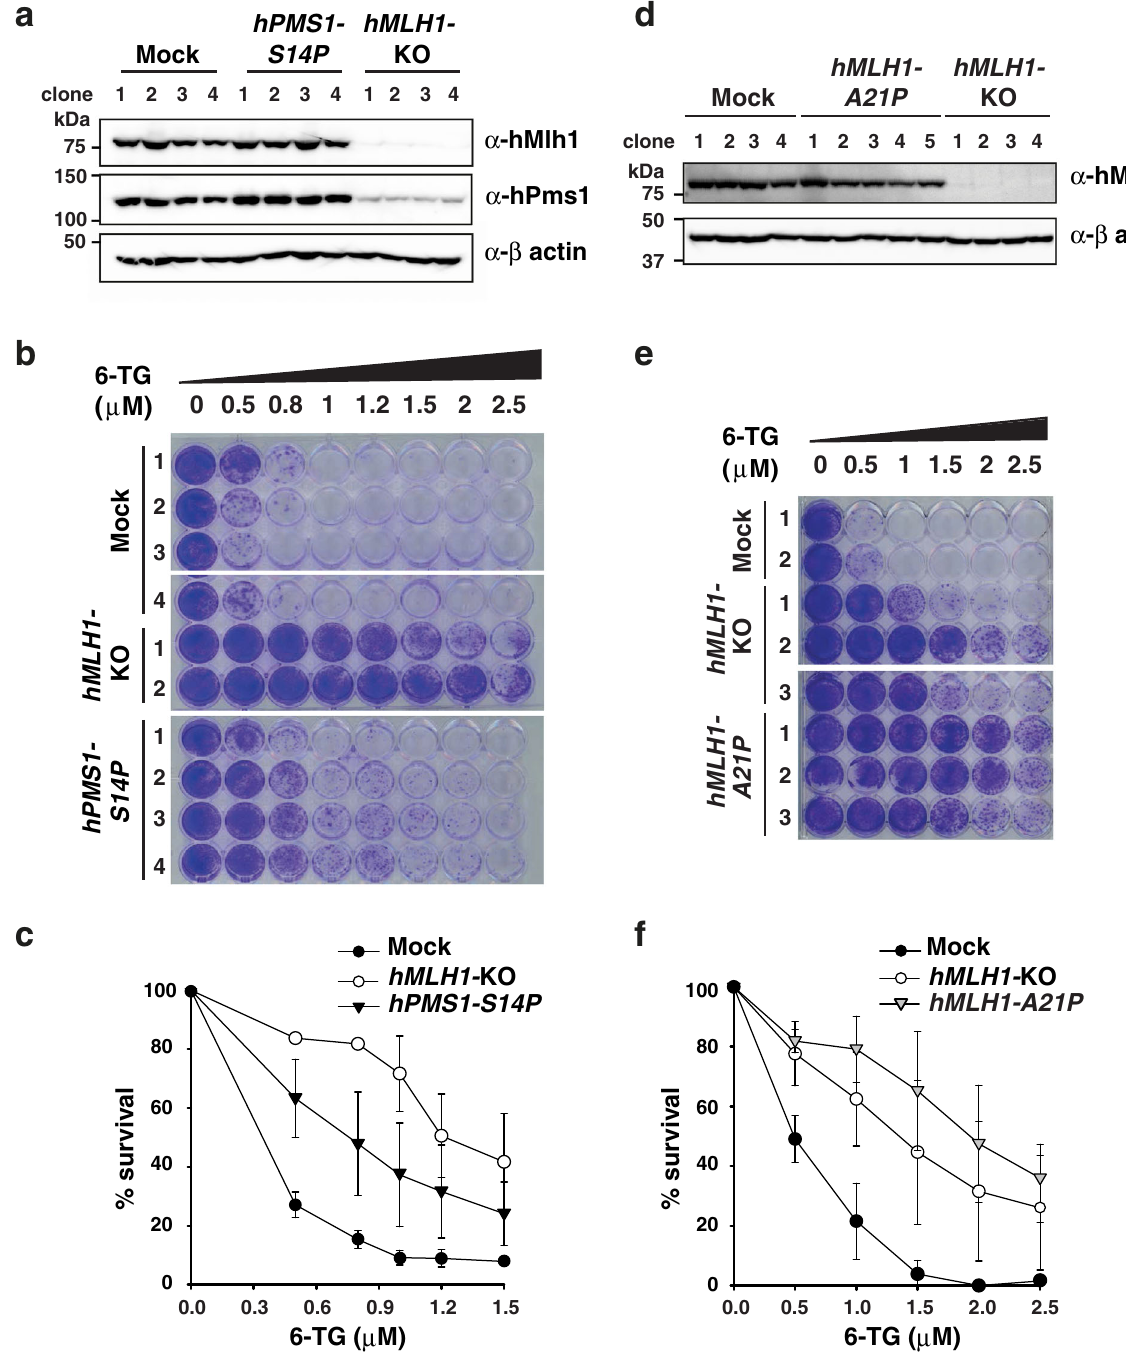
Fig. 5 hPMS1-S14P and hMLH1-A21P mutant alleles confer mutator phenotype in human HAP1 cells. a hPMS1 and hMLH1 expression levels in CRISPR/ Cas9-edited hPMS1-S14P and hMLH1- KO cell lines, determined by Western blot. Actin was used as a loading control. b Qualitative mutator analysis showing increased resistance to 6-TG in hMLH1- KO and hPMS1-S14P cells compared to mock cells. Cells were treated with 6-TG at the indicated concentration for 7 days and were stained with crystal violet. c Survival curves for hMLH1- KO ( n = 4, biologically independent clones) and hPMS1-S14P cells ( n = 4, biologically independent clones) based on a colony-formation assay after 12 days of treatment with different concentrations of 6-TG. d Western blot analysis showing hMLH1 expression levels in the indicated cell lines. e Qualitative mutator analysis (as shown in b ) for the indicated cell lines. f 6-TG survival curves for HAP1-mock ( n = 6, biologically independent clones), hMLH1- KO ( n = 4, biologically independent clones), and hMLH1-A21P ( n = 3, biologically independent clones), determined as in c . For c and f , error bars represent standard deviation of the mean of the data